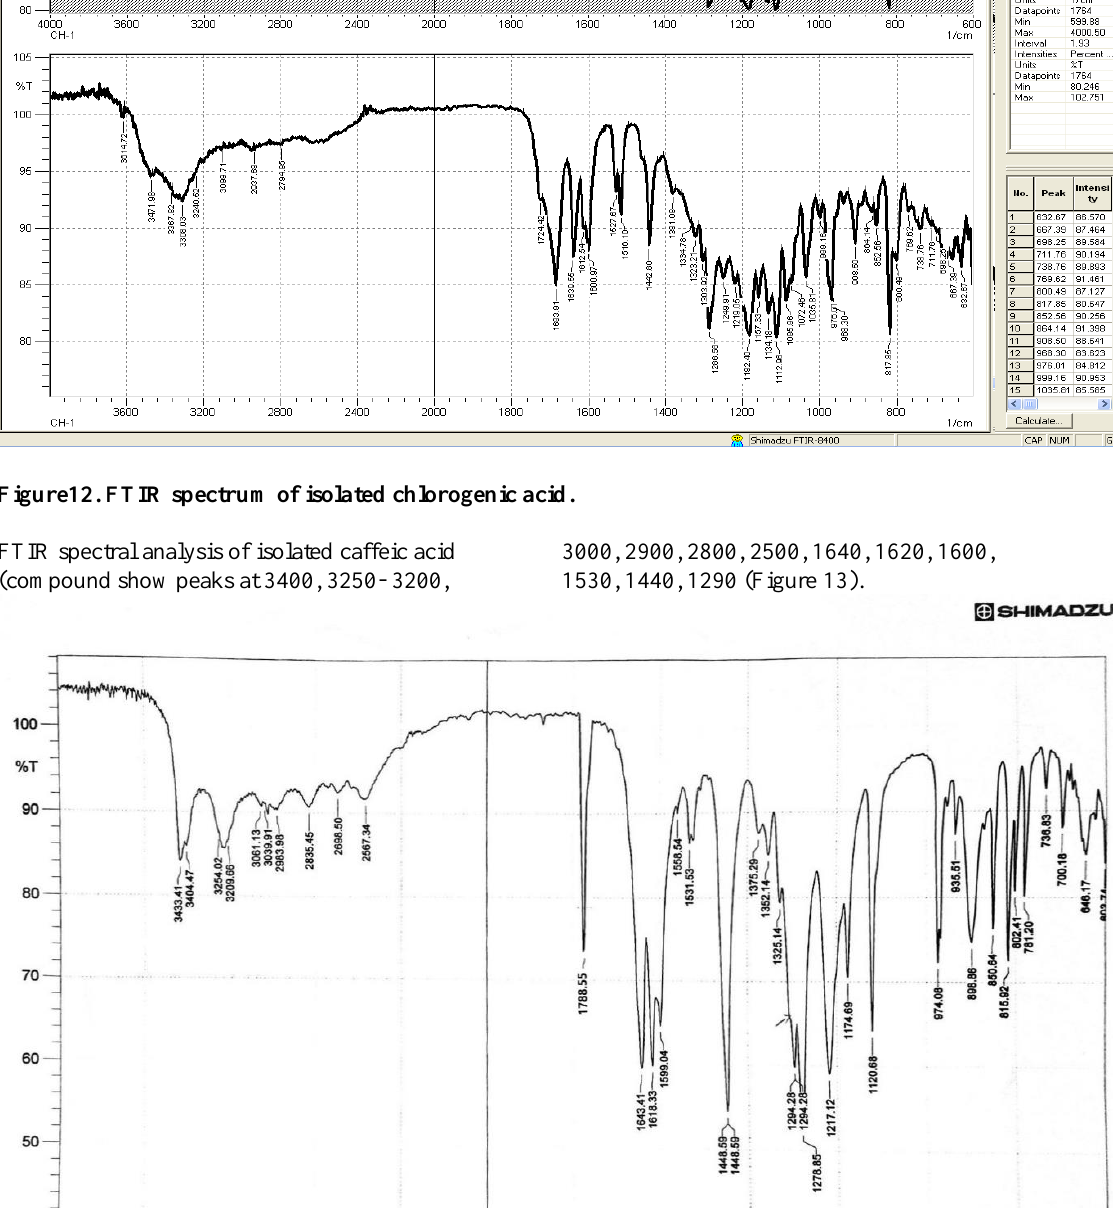
Figure13. FTIR spectrum of isolated caffeic acid. FTIR spectral analysis of isolated luteolin compound show peaks at 3400-3000, 2700,